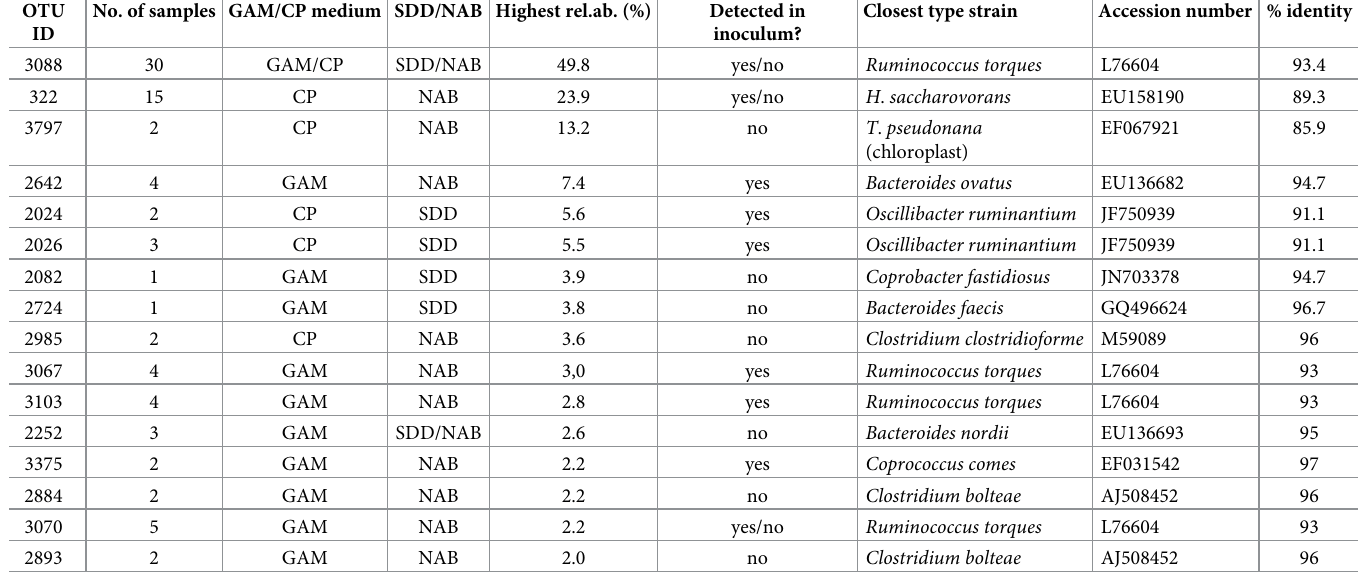
The relative abundance of the listed taxa was � 2% on at least one PAO